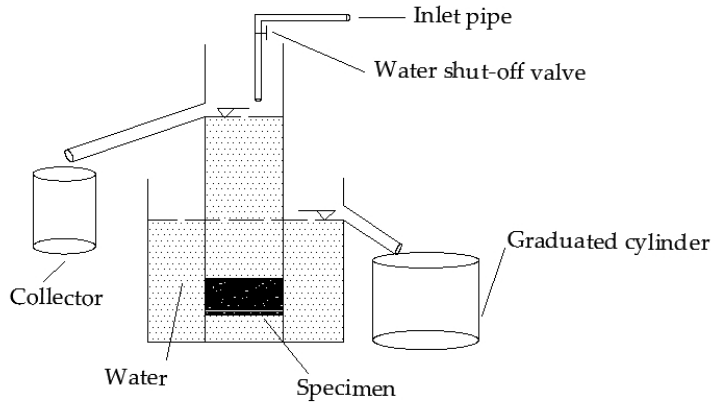
Figure 3. Schematic diagram of apparatus.